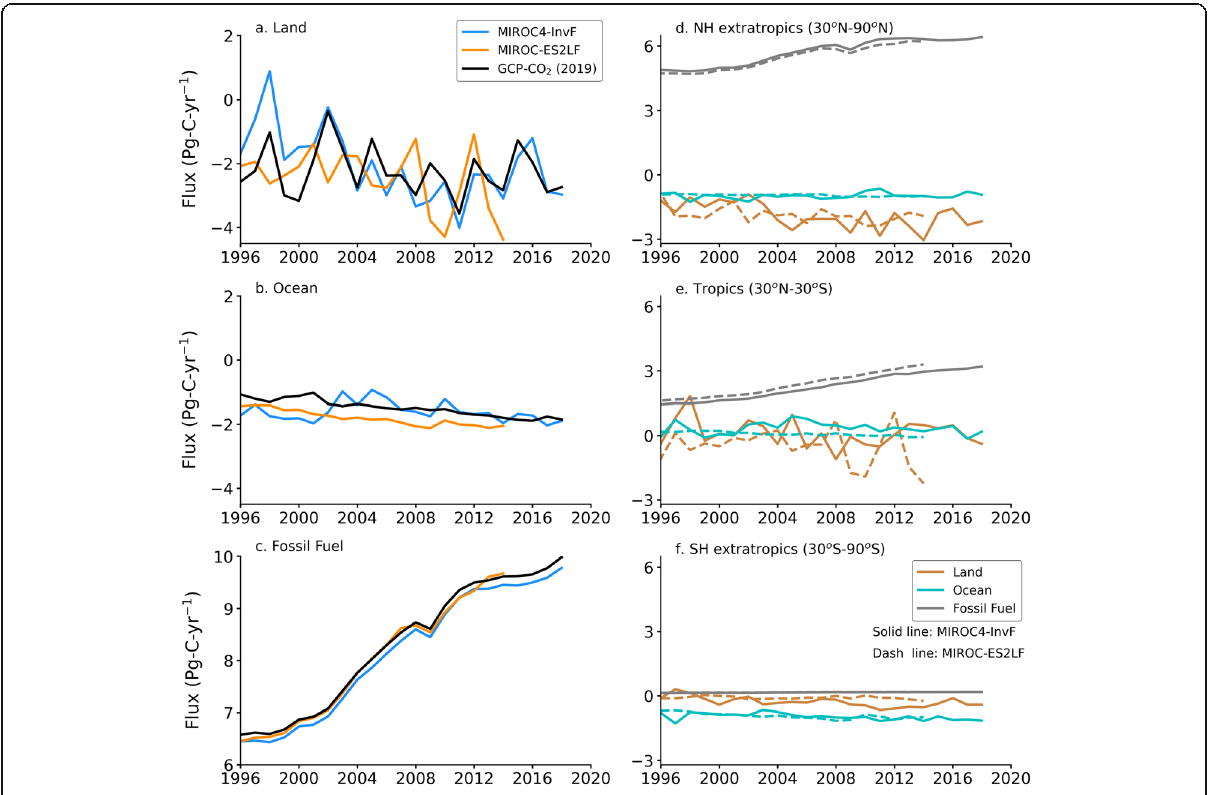
Fig. 2 Time series of global (left column) and semi-hemispheric (right column) total CO 2 fluxes for land and ocean at annual intervals as estimated by the MIROC4-Inv and MIROC-ES2L (panels a and b , respectively). The FFC emissions from independent data sources are also compared (panel c ). The global total results are compared with GCP-CO 2 budgets (Friedlingstein et al. 2020). The semi-hemispheric biospheric fluxes of land and ocean regions as well as the FFC emissions are shown (right column), for the northern hemisphere (NH) extratropics, tropics, and southern hemisphere (SH) extratropics (panels d – f , respectively). Please note the different y -axis range for each panel (the ocean flux variability in panel b may appear deceivingly large compared with the land flux variability in panel a